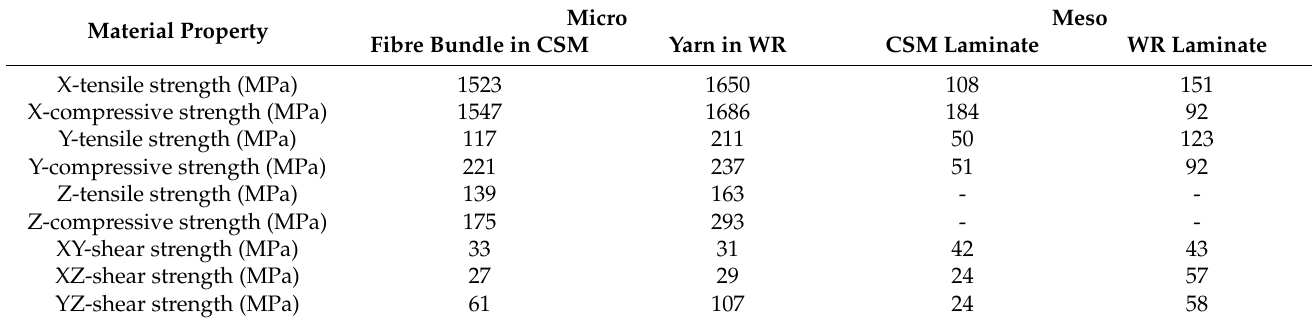
Table 4. Micro- and meso-scale strengths in CSM and WR